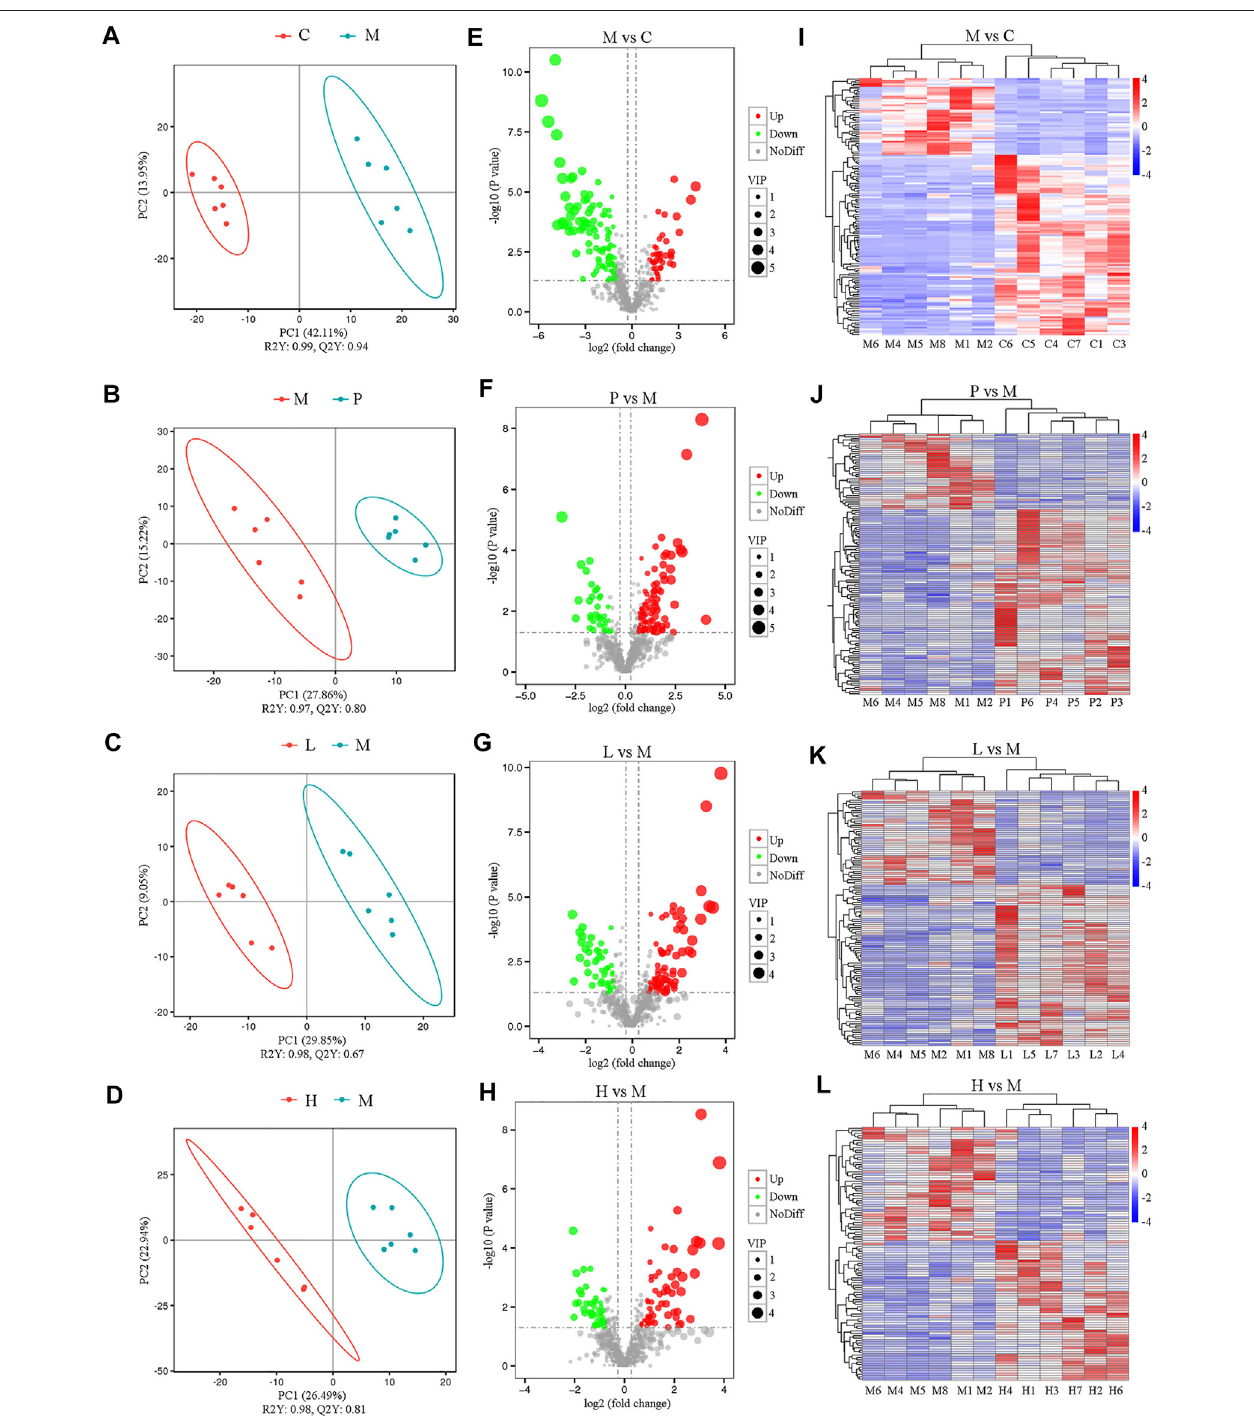
FIGURE 4 | Metabolomic analysis among fi ve groups under the positive ion mode ( n = 6). The separation of two groups was accessed by partial least square- discriminateanalysis(PLS-DA)[ (A) Mvs.C; (B) Pvs. M; (C) Lvs.M;and (D) Hvs. M].Volcano plotindicatesthedifferentiallyexpressed metabolitesbetweenthegroups [ (E) Mvs.C; (F) Pvs.M; (G) Lvs.M;and (H) Hvs.M].Heatmapshowsthedifferentialexpressionofmetabolitesbetweengroups[ (I) Mvs.C; (J) Pvs.M; (K) Lvs.M;and (L) H vs. M].